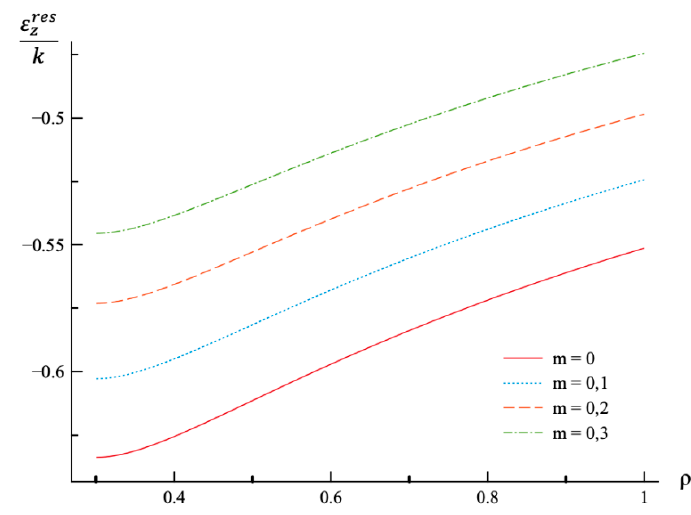
Figure 10. Variation of the residual axial strain, ε res z , with the dimensionless radius, ρ